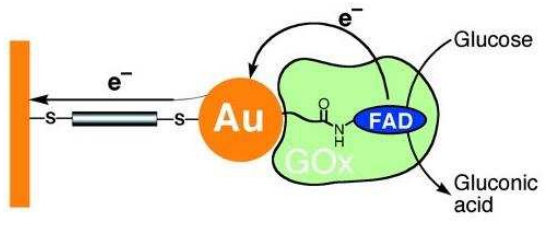
Figure 2. A schematic representation of a gold nanoparticle-reconstituted glucose oxidase electrode. From Xiao et al . Science 2003 , 299 , 1877-1881. Reprinted with permission from